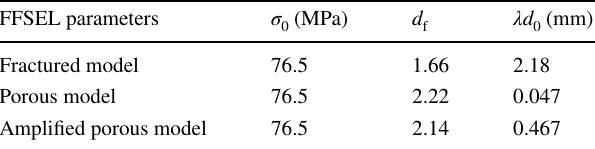
Table 3 The obtained parameters required in the FFSEL model for different printed